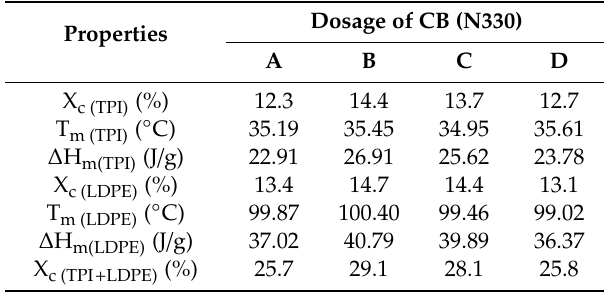
Figure 1. E ff ect of CB dosage on DSC curves of TPI / LDPE composites, ( a ) cooling curves and ( b ) Figure 1. Effect of CB dosage on DSC curves of TPI/LDPE composites, ( a ) cooling curves and ( b ) heating curves. heating curves. Table 4. E ff ect of CB dosage on crystallinity of TPI / LDPE Table 4. Effect of CB dosage on crystallinity of TPI/LDPE composites.